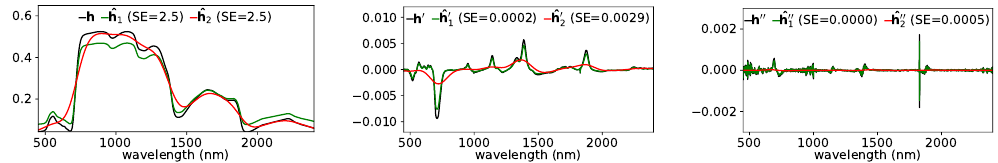
Figure 3. Comparison of magnitude, first derivative, and second derivative of the original spectrum ( h ) and two reconstructions ( ˆ h 1 and ˆ h 2 ) . SE is the squared Euclidean distance between the original and